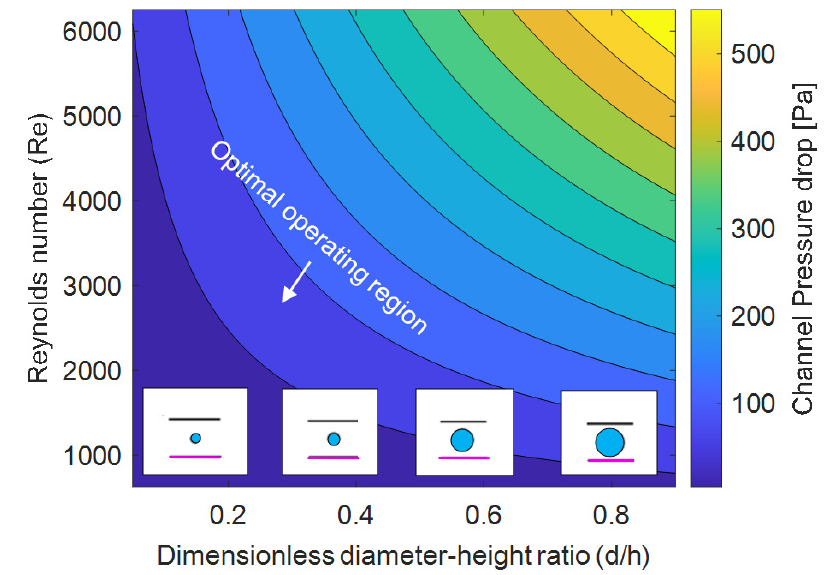
Figure 6. Pressure drop analysis. There are substantial changes in pressure drop once the flow is turbulent (Re > 2300) and larger diameters also cause substantial pressure penalties. T in = 27 ℃ , RH in = 70%, T coil = 10 ℃ , L × H × W = 0.8 m × 0.006 m × 0.3 m, N coils = 8, h cs = 0.006 m, L cs = 0.08 m, B = 5000 GPU.